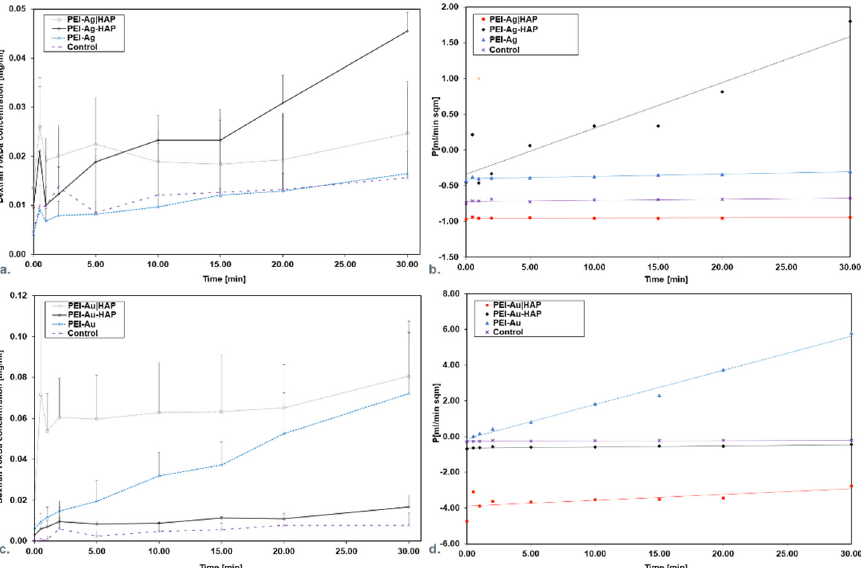
Figure 4. Dextran 70 concentration in the function of time during permeation through the membrane scaffolds containing silver ( a ) or gold ( c ) nanoparticles. Membrane permeability and time product during particular time intervals permeation for Dextran 70 through the membrane scaffolds containing silver ( b ) or gold ( d ) nanoparticles. Key to symbols: PEI-Ag: polyethyleneimine with AgNPs; PEI-Ag|HAP: polyethyleneimine with AgNPs—hydroxyapatite; PEI-Ag-HAP: polyethyleneimine with AgNPs and HAP complex. PEI-Au: polyethyleneimine with AuNPs; PEI-Au|HAP: polyethyleneimine with AuNPs—hydroxyapatite; PEI-Au-HAP: polyethyleneimine with AuNPs and HAP complex. The values are presented as mean ± SD.